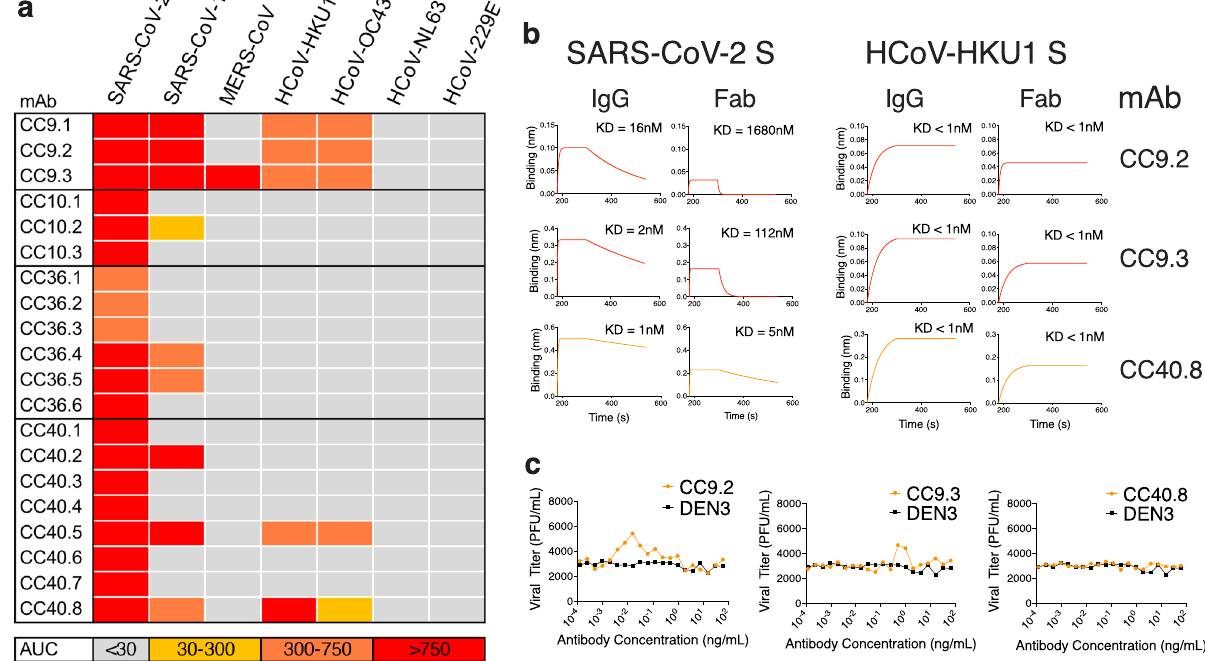
Fig. 4 Binding and ADE of SARS-CoV-2/HCoV-HKU1 S-protein-speci fi c cross-reactive mAbs. a Heatmap showing CELISA binding of COVID mAbs to seven HCoV spikes. Binding represented as area-under-the-curve (AUC) is derived from CELISA-binding titrations of mAbs with cell surface-expressed HCoV spikes and the extent of binding is color-coded. Five mAbs show cross-reactive binding across β -HCoV spikes. b BLI of SARS-CoV-2 and HCoV- HKU1 S-protein-speci fi c cross-reactive mAbs. BLI binding of both IgG and Fab versions of three cross-reactive mAbs (CC9.2, CC9.3, and CC40.8) to SARS- CoV-2 and HCoV-HKU1 S-proteins was tested and the binding curves show association (120 s; 180 – 300) and dissociation rates (240 s; 300 – 540). BLI binding of antibody-S-protein combinations shows more stable binding (higher binding constants (KDs)) of cross-reactive mAbs HCoV-HKU1 compared to the SARS-CoV-2 S protein. c Antibody-dependent enhancement (ADE) activities of cross-reactive mAbs, CC9.2, CC9.3, and CC40.8 binding to SARS- CoV-2 live virus using Fc γ RIIa (K562) and Fc γ RIIb (Daudi)-expressing target cells. A dengue antibody, DEN3, was used as a control. Each data point in the curve is derived from the ADE experiment of mAbs with SARS-CoV-2 virus and shows virus titer obtained from technical replicates ( n = 2); data representative of two independent